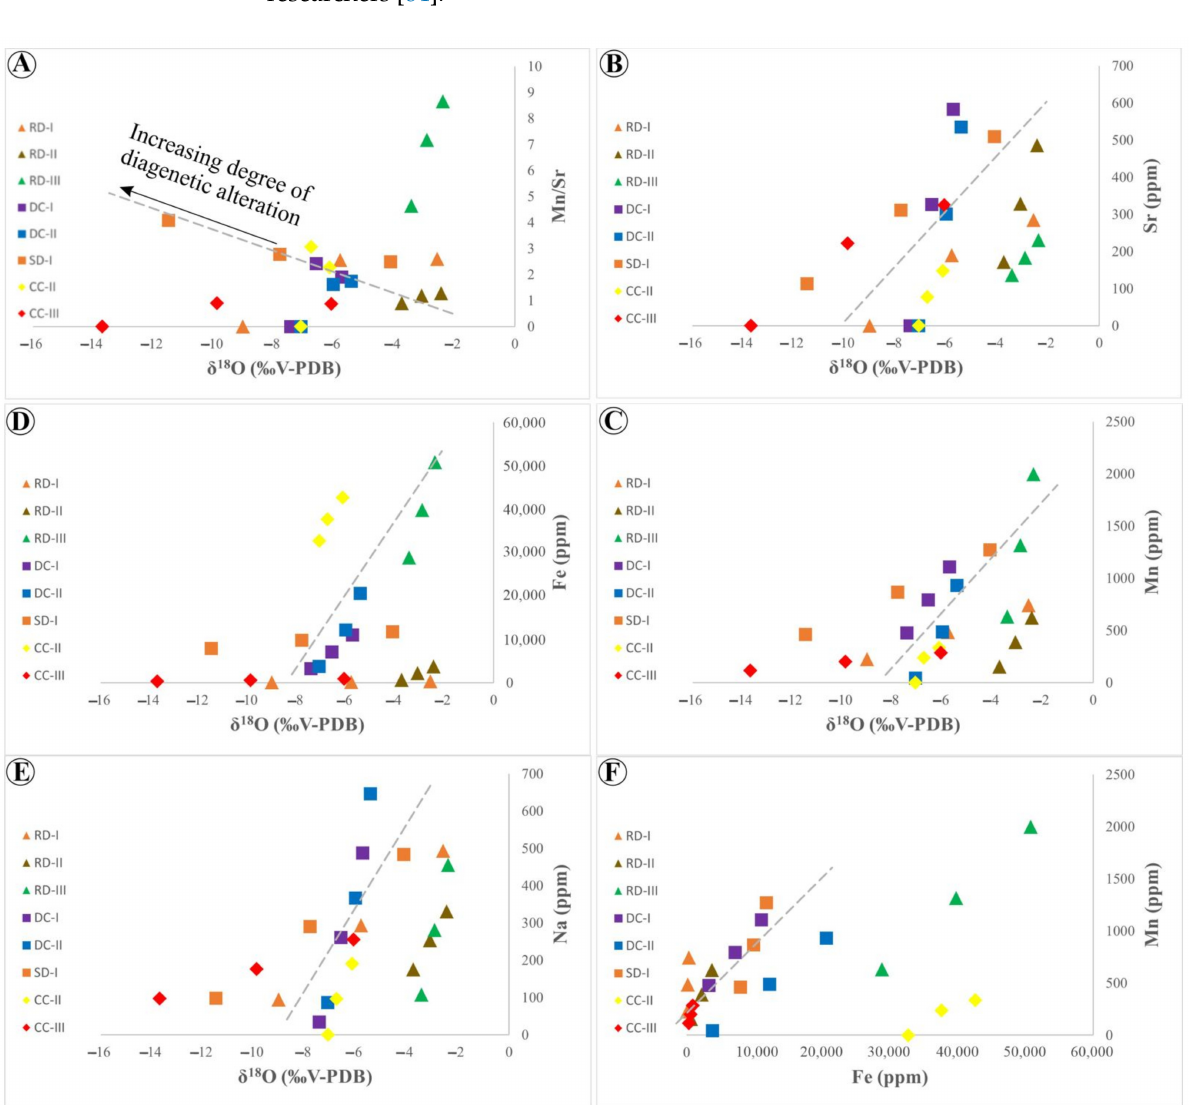
Figure 12. ( A ) Cross plot of δ 18 O vs. Mn/Sr indicates the increasing degree of diagenetic alterations associated with increasing burial depth and depletion in δ 18 O. ( B – E ) Different cross plots of δ 18 O vs. elemental composition (i.e., Fe, Sr, Na, and Mn) of the dolomite and calcite phases. It is important to mention that RD-III and CC-II possess abnormal high values of Fe illustrated in these cross plots. RD-III is iron rich ferroan dolomites, while CC-II indicates the dedolomite phase of diagenetic alterations. In most of the studied thin sections, pyrite mineralization and iron leaching are closely associated with CC-II, that is why the concentration of Fe is very high. Similarly, depletion in δ 18 O reflects increase in burial depth as observed in these cross plots. ( F ) Cross plot of Fe vs. Mn, exhibit a decrease in Fe contents and an increase in reducing conditions during the burial phases of diagenetic